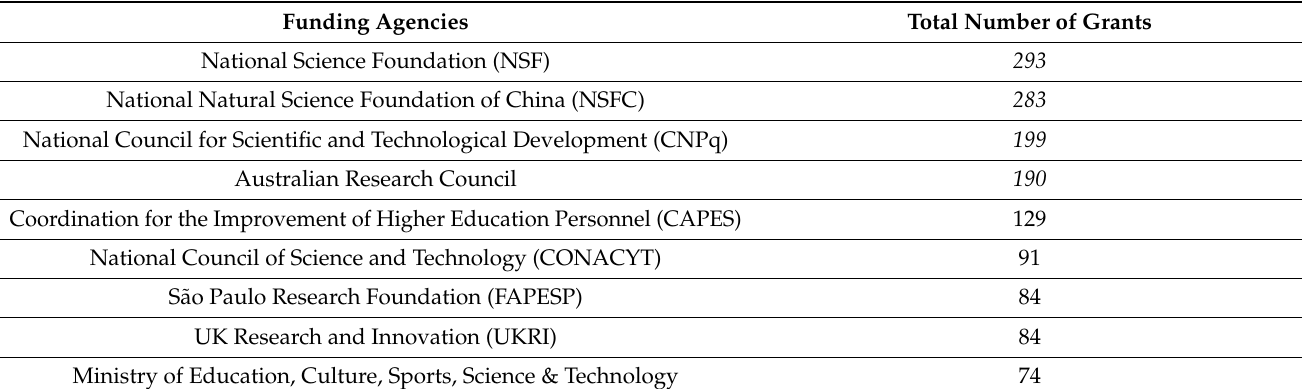
Figure 4. An interactive illustration of the cooperation network among countries that have published research on the impact of climate change on mangroves from 1977–2021. The lines connecting the nodes represent the strength of connections between research fields, with thicker lines indicating a higher intensity of connections. The size of the nodes signifies the frequency of co-occurrence in the research fields. The nodes are color-coded to represent the year of publication, e.g., red representing 2021, yellow representing 2019, blue representing 2015, and purple representing 2012. Table 2. Top 10 major grant providers related to climate impact on mangrove research.